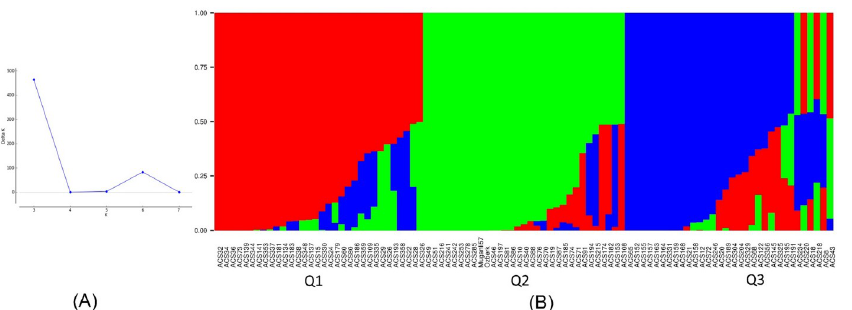
Fig 1. (A) Delta K values for different numbers of populations assumed (K) in the STRUCTURE analysis. (B) Classification of 95 sesame accessions into three populations (K = 3) using STRUCTURE v2.3.4. Each accession is represented by a single row, which is partitioned into colored segments in proportion to the estimated membership in the three subpopulations. Numbers on the y-axis show the subgroup membership, and the x-axis shows the different accession.